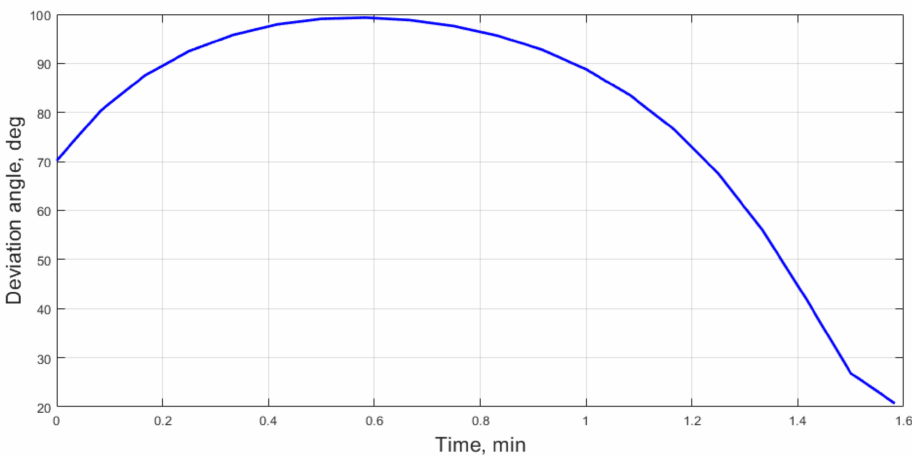
Figure 18. Deviation of OZ axis from the direction of the incoming air flow.